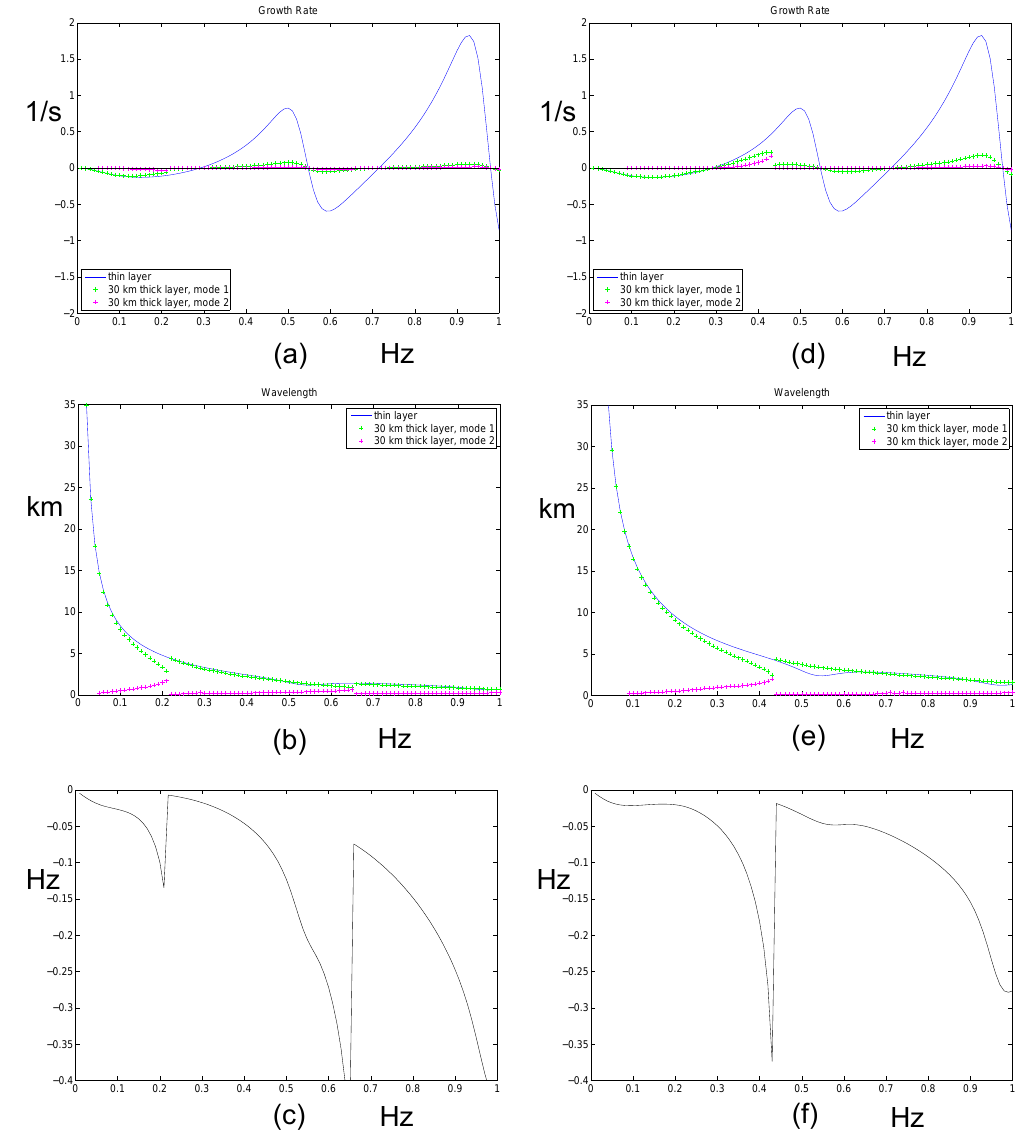
Fig. 5. Growth rate, wavelength, and frequency in the earth-fixed frame, plotted versus frequency in the frame moving with the E 0 × B velocity, for a 100km altitude layer. Panels (a) through (c) are for E 0 = 50 mVm − 1 . Panels (d) through (f) are for E 0 = 100 mVm − 1 . The green (purple) lines show results for the mode with the largest (second largest) growth rate for a 30km thick layer. The blue lines show results for a thin auroral layer of the same integrated conductivity. The results for the frequency in the earth-fixed frame (black lines) are shown only for the mode with the largest growth rate when the layer is 30km thick (i.e., for the green lines). The integrated Pedersen and Hall conductivities are 0.29mhos and 9.61mhos, respectively, which corresponds to a 30km thick layer with an electron density of 10 11 m − 3 .